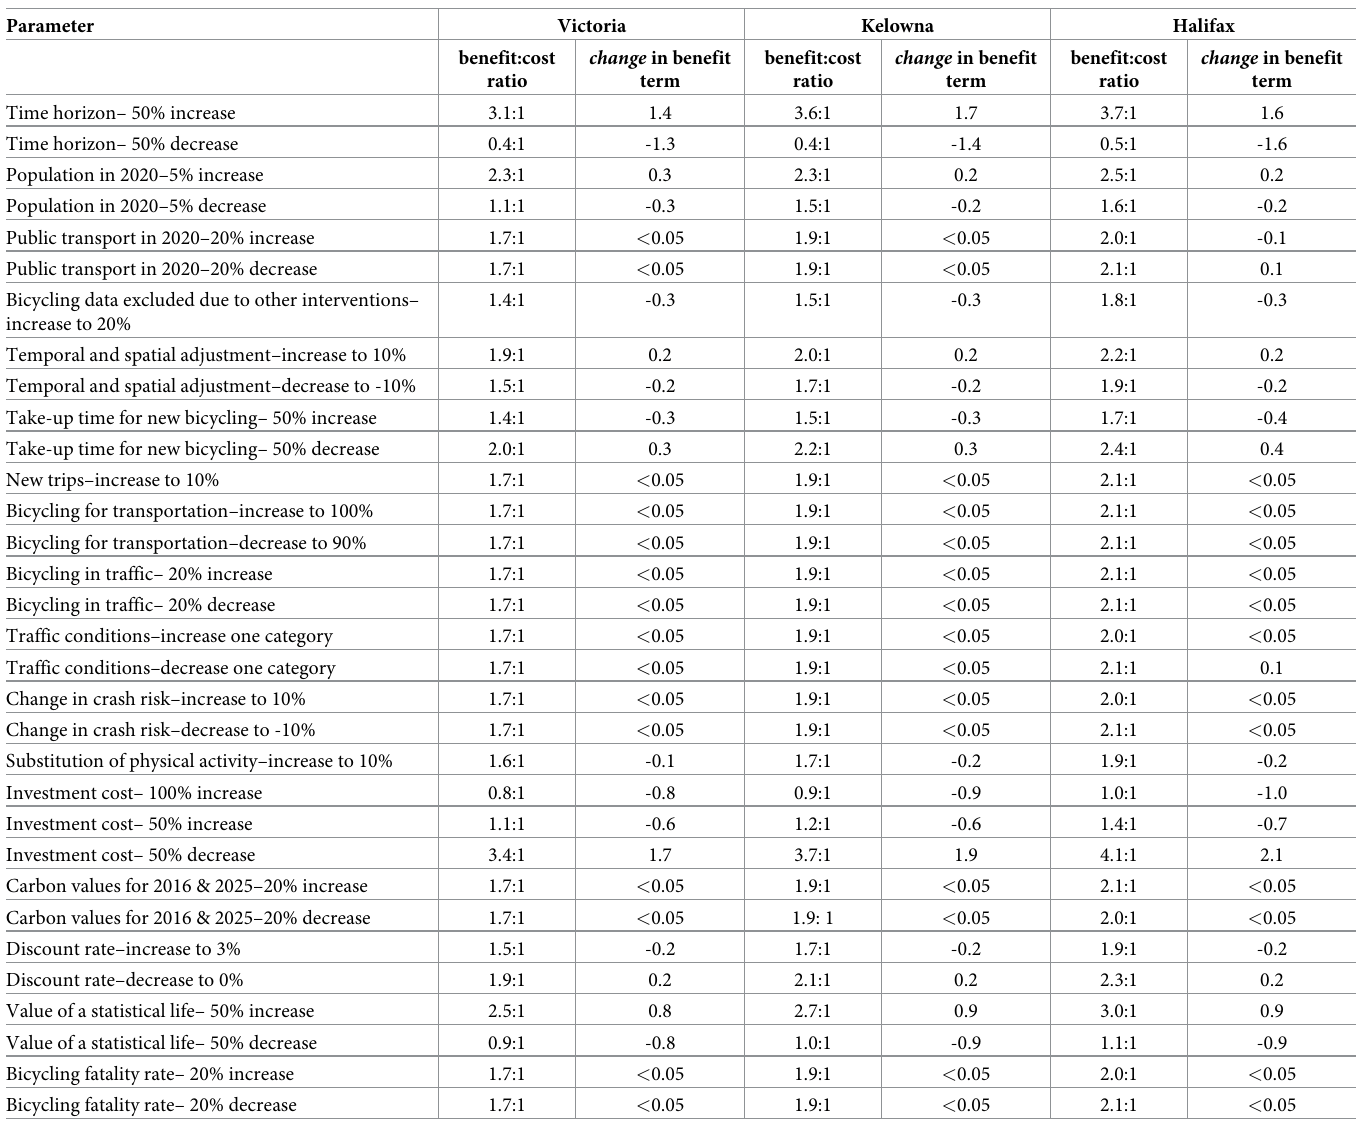
a The benefit:cost ratios reported in S3 Table correspond to the sensitivity analyses described in S2 Table. Different wording is used to differentiate between absolute (e.g., ‘increase to 10%’) and relative (e.g., ‘10% increase’) changes to parameters. Benefit:cost ratios for all analyses–primary and sensitivity–are reported to one decimal place. These rounded estimates were not used in the calculation of the change in the benefit